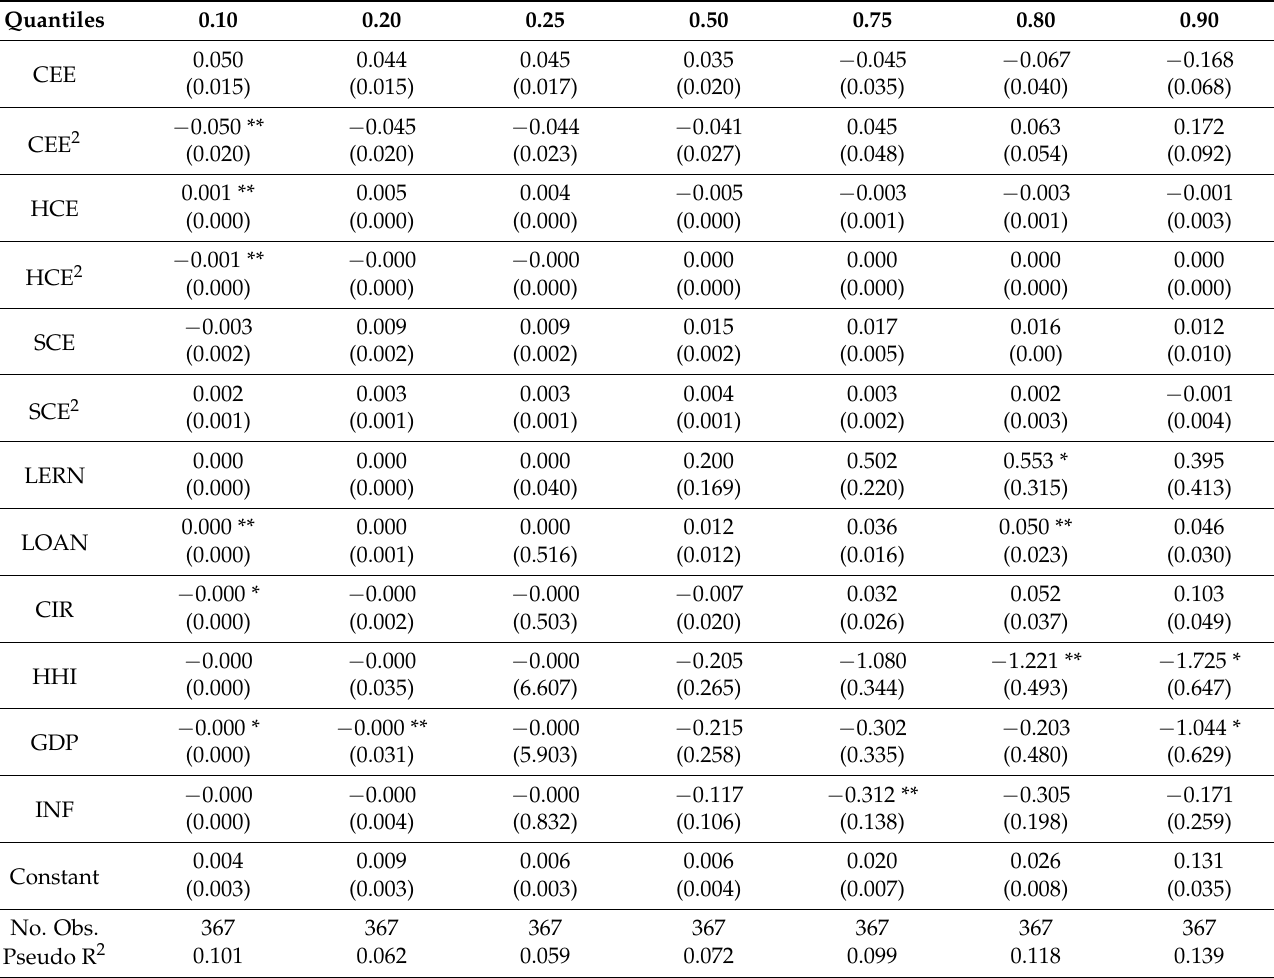
Table 7. Baseline results for NPL and VAIC’s components: Quantile